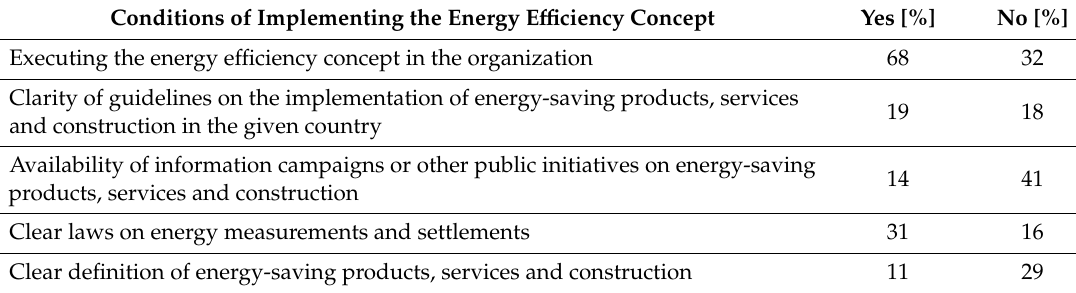
Table 1. Level of implementation of the energy e ffi ciency concept in EU enterprises.